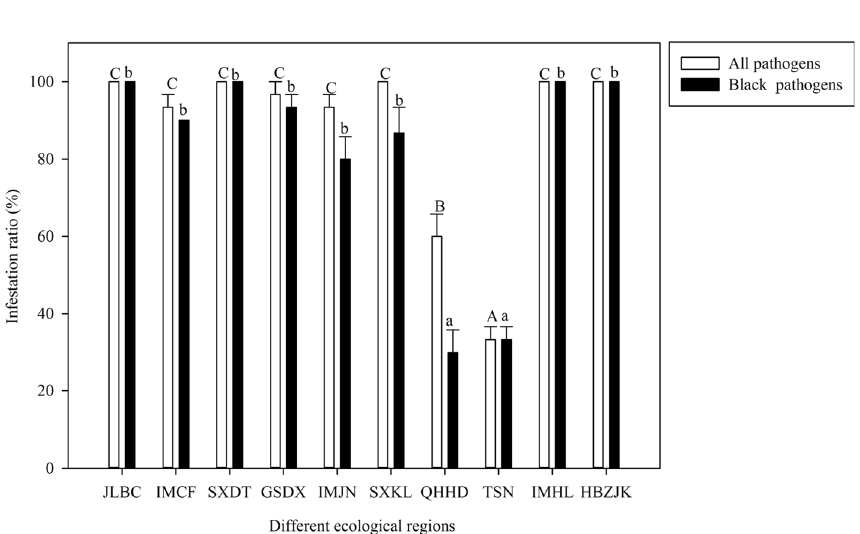
Figure 4. The comparison of infections by fungal pathogens after 5 days of culture on PDA on the surface of Bayou 13 grains from 10 ecological regions, China. The white and black columns represent the means for all pathogens and black pathogens, respectively, and the bars represent the SE. Different uppercase letters and lowercase letters above the columns indicate significant differences within the ten regions (least significant difference test, P < 0.05) for all pathogens and black pathogens, respectively. SXKL, TSN, QHHD, SXDT, GSDX, IMCF, IMJN, IMHL, HBZJK and JLBC indicate Kelan County in Shanxi Province; Shannan Prefecture in